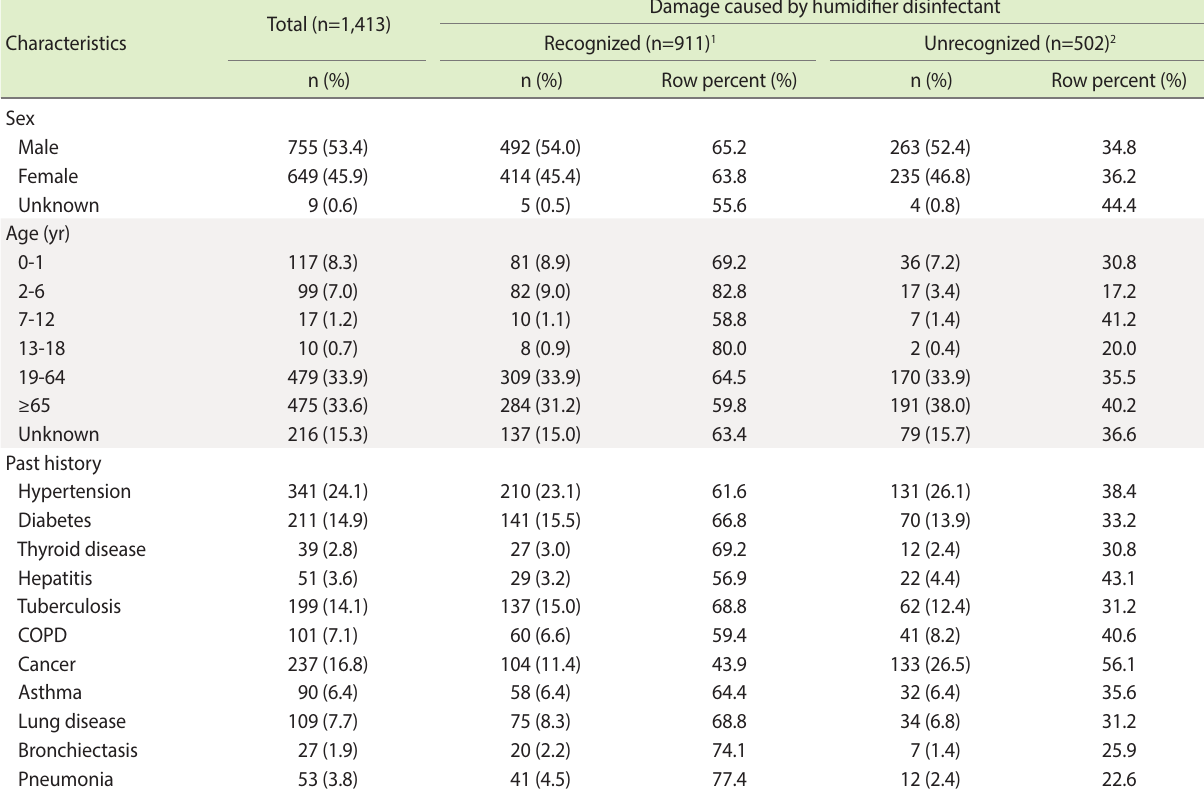
Table 1. Deceased victims’ general characteristics